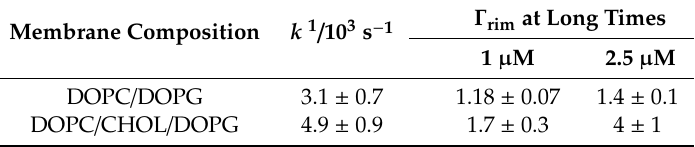
Table 2. Parameters for the interaction between the fluorescently marked peptide and GUVs. Apparent constant for the kinetics of adsorption ( k ), and maximal value of fluorescence at the rim normalized by the fluorescence outside the GUV ( Γ rim at long